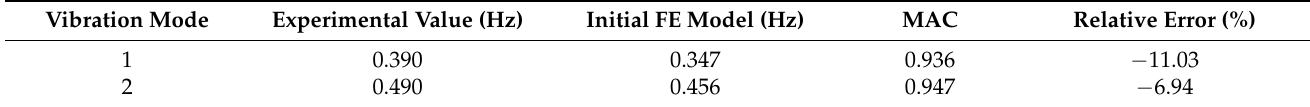
Figure 11. Measured vibration mode and calculated vibration mode MAC: ( a ) first order mode and ( b ) the second mode. Table 6. Calculated value and test value of frequency.